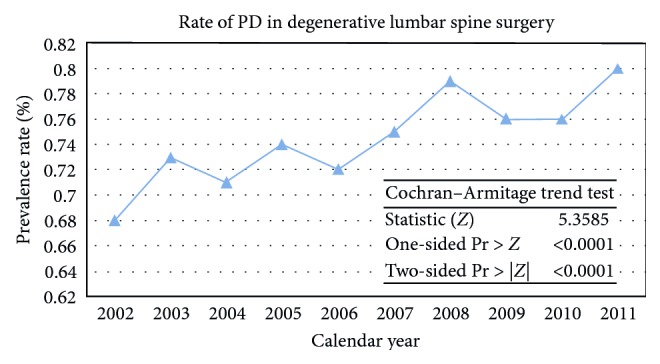
Stock plot demonstrating increased prevalence of Parkinson's disease patients undergoing lumbar spine surgery for degenerative conditions between the years 2002 and 2011.